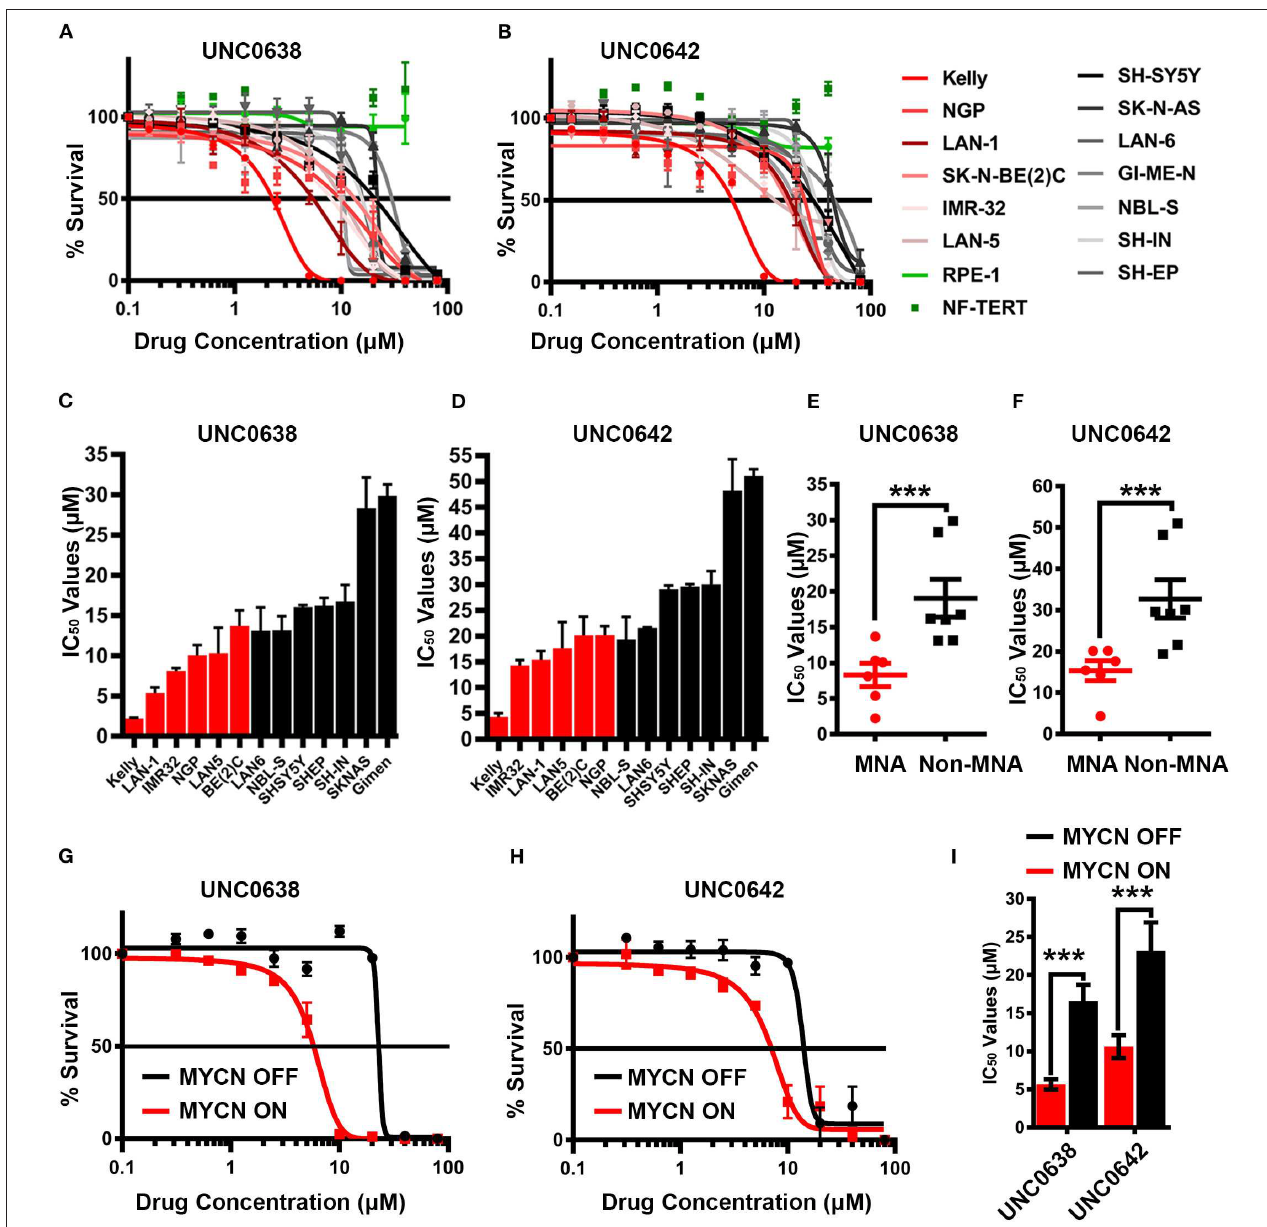
FIGURE 5 | Sensitivity of neuroblastoma cell-lines to G9a inhibitors UNC0638 and UNC0642. (A) Thirteen neuroblastoma cell lines, including six MYCN -amplified (shades of red lines), seven non- MYCN -amplified (shades of black lines), and two non-cancerous cell lines (shades of green lines) were screened by MTT based cell proliferation assay after 72h to determine sensitivity to G9a SMI UNC0638. 0.0 µ M was plotted as 0.1 µ M, to be able to chart on log scale. Error bars show SEM. n ≥ 3. (B) MTT assay of 13 NB and two normal cell lines using G9a SMI UNC0642. (C) Bar chart of IC 50 values for UNC0638 with all cell lines. Error bars show SEM. (D) Bar chart of IC 50 values with UNC0642. Error bars show SEM. (E) MTT assay based IC 50 values for UNC0638 from (A) are visualized as a scatterplot between MNA and non-MNA cell lines. Error bars show the SEM. *** p < 0.01, unpaired t test. (F) —MTT assay based IC 50 values for UNC0642 from (B) are visualized as a scatterplot between MNA and non-MNA cell lines. Error bars show the SEM. *** p < 0.01, unpaired t -test. (G) S21N cell line with and without induced MYCN were screened by MTT based cell proliferation assay after 72h to determine sensitivity to G9a inhibitors UNC0638. 0.0 µ M was plotted as 0.1 µ M to chart on log scale. Error bars show SEM. N = 3. (H) MTT assay of induced and uninduced S21N cells using UNC0642. (I) —Bar chart of S21N IC 50 values with and without induction. Error bars show the SEM. *** p < 0.01, unpaired t -test.